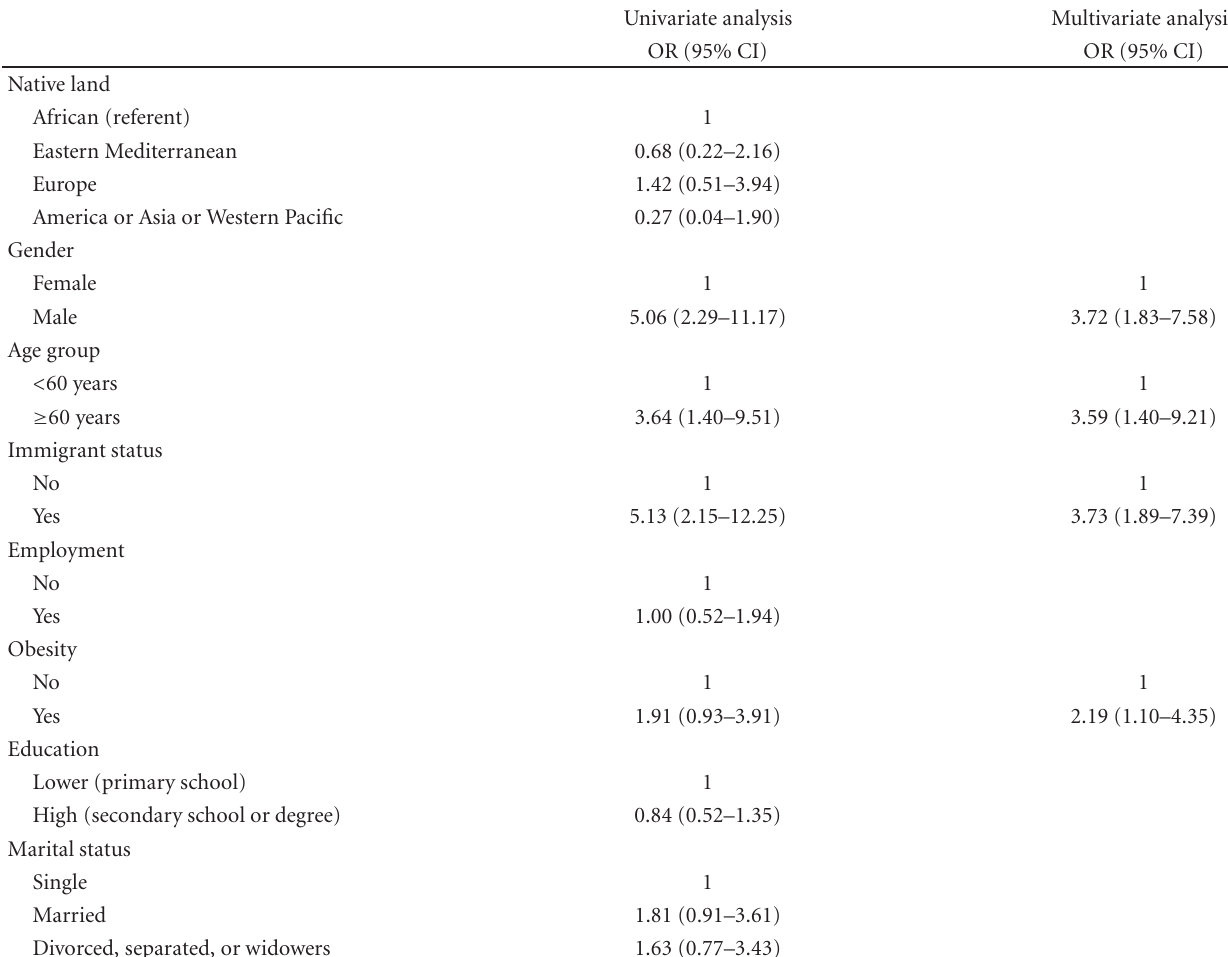
Table 3: Results of the multivariate approach performed in order to find statistically significant determinants of LTBI. (OR: Odds Ratio; CI: Confidence